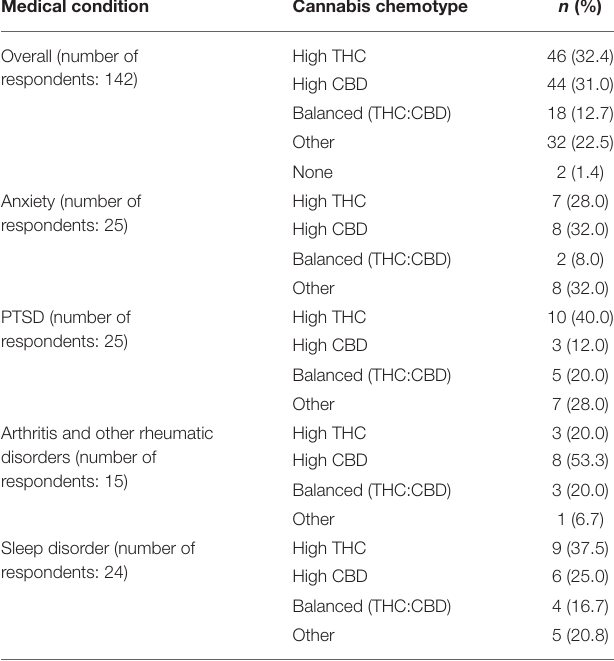
TABLE 7 | Information on preferred cannabis chemotypes for each of the top medical conditions reported by patients after 6 weeks of medical cannabis treatment.